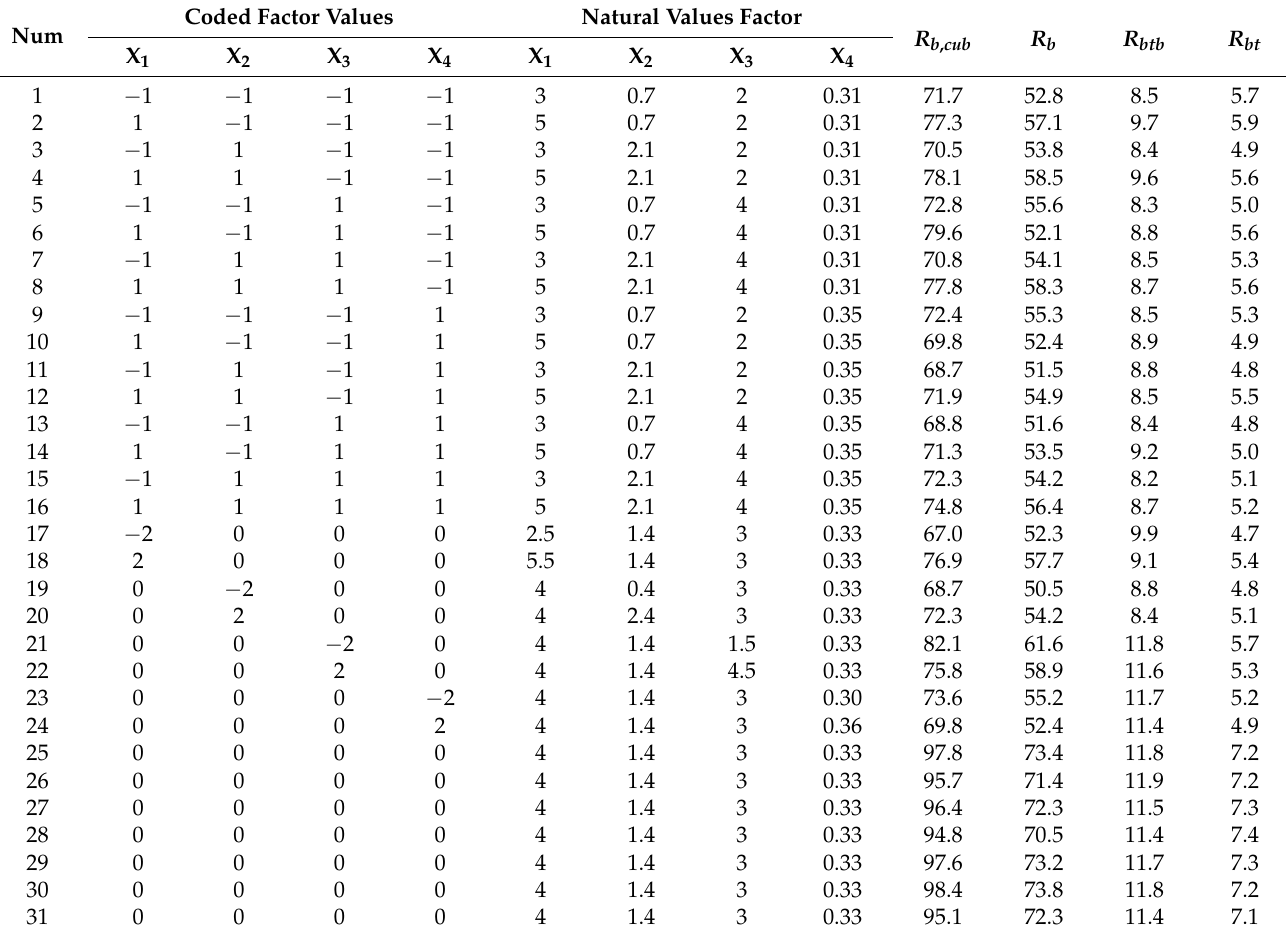
Table 9. Results of determining the strength characteristics of high-strength